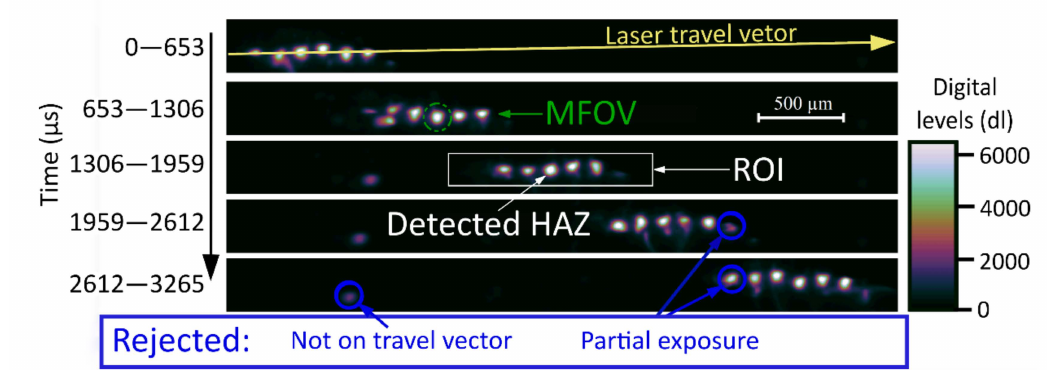
Figure 4. An example of a series of images captured using the setup in Figure 2. Each image is subsequent to the image above it in time, shown in µ s on the left. An example Region of Interest (ROI) for a detected Heat Affected Zone (HAZ) is displayed in the white box. The MFOV is displayed as a green circle in the second image. Examples of three rejected hot spots are illustrated, highlighted with blue arrows, and